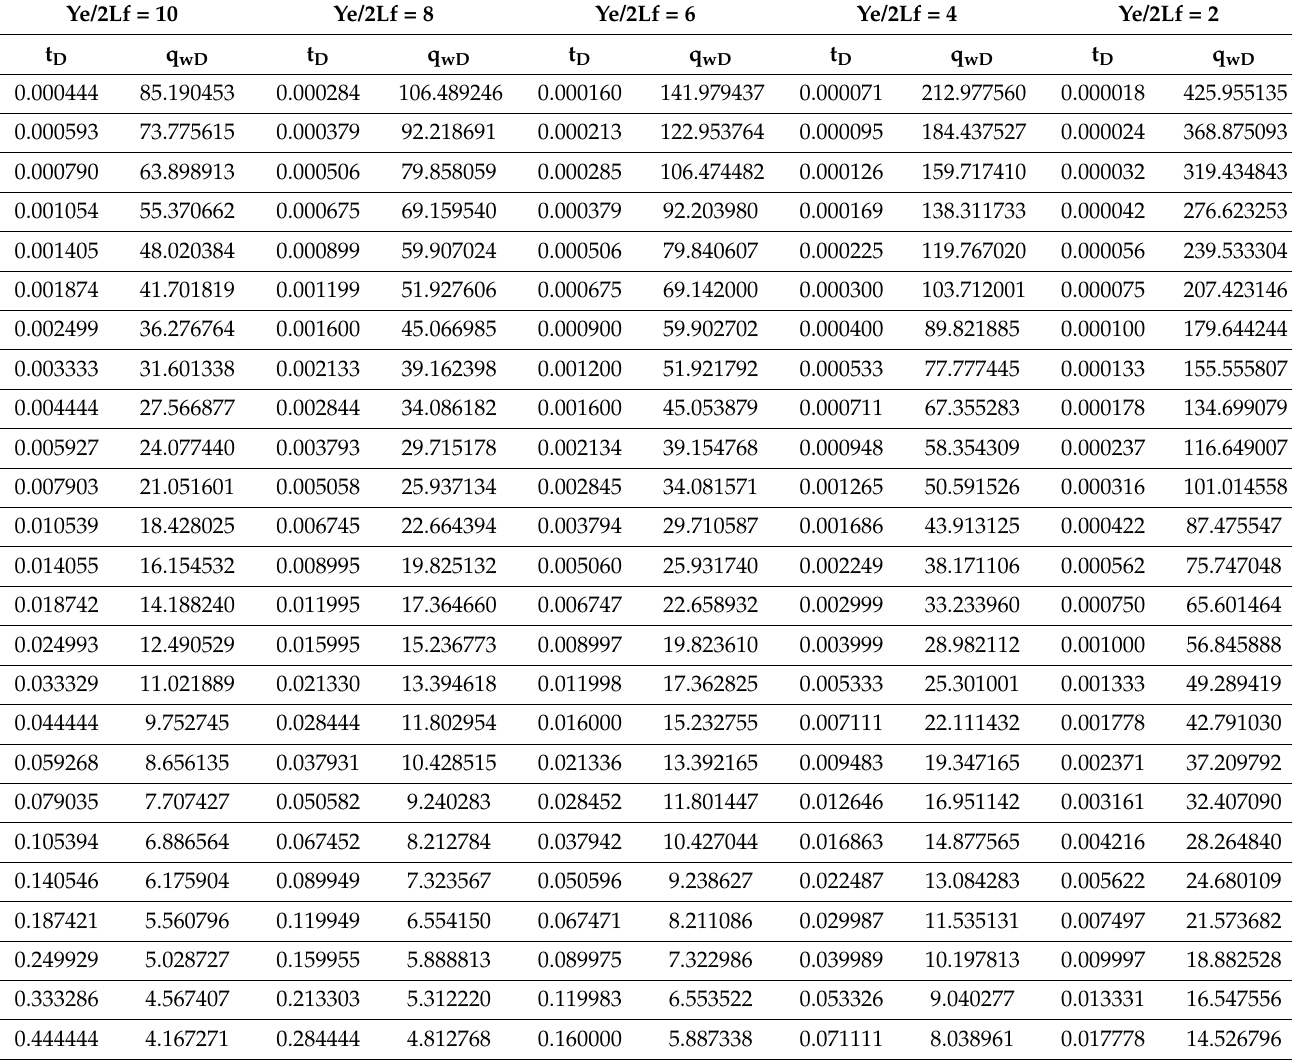
Table A2. Computing results based on the parameters provided in Table A1, shown in Figure